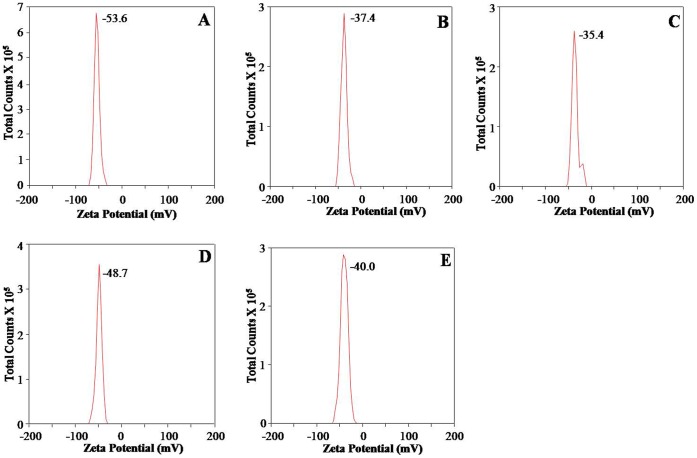
Zeta potential measurements of PLA NPs synthesized using PEs as stabilizer/emulsifier.(A) PLA-1 (B) PLA-2 (C) PLA-3 (D) PLA-4 (E) PLA-5. One ml of each PEs synthesized PLA NPs was taken in disposable zeta cells for recording zeta potential on Zeta sizer Nano ZS. All the NPs showed zeta potential more than −30 mV indicating good stability.